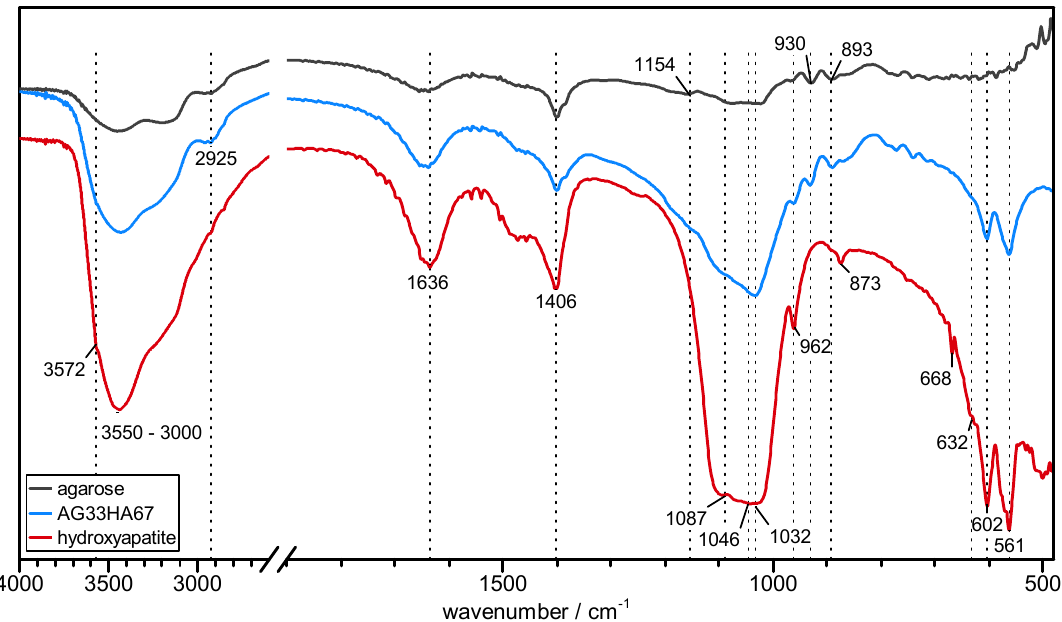
Figure 2. FT-IR spectra of agarose (black), hydroxyapatite (red), and agarose/hydroxyapatite composite (AG33HA67;